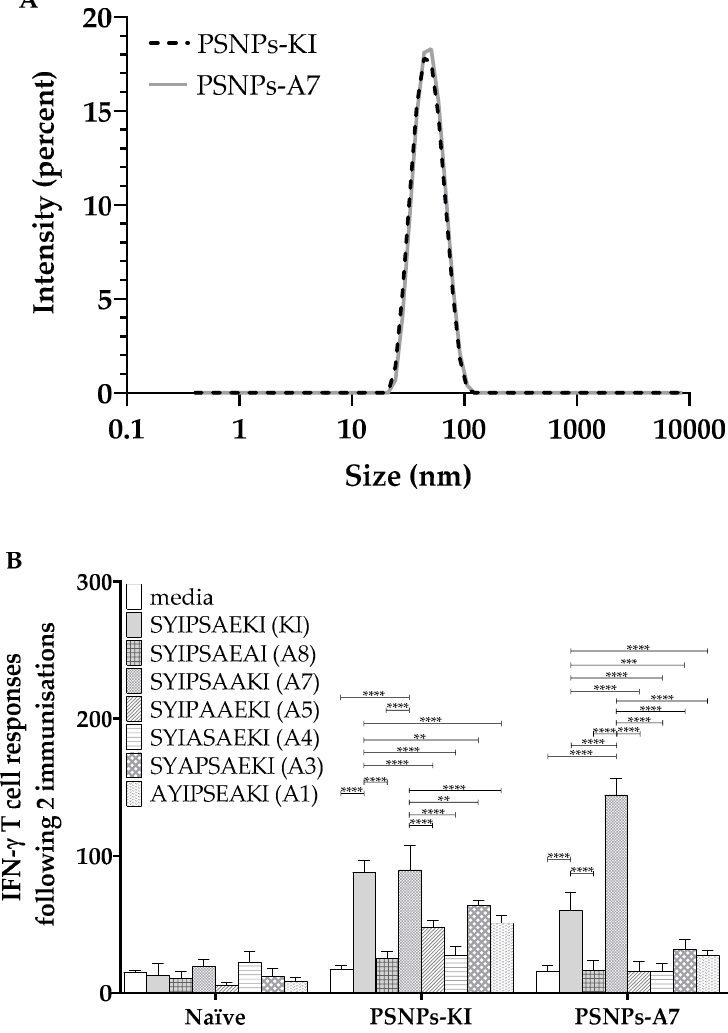
Figure 4. Cross-reactivity to both SYIPSAAKI (A7) and SYIPSAEKI (KI) when either peptide is conjugated to PSNPs. KI and A7 peptides were conjugated to PSNPs and sizes measured on a Malvern zetasizer ( A ). The 6–8 week old BALB/c mice were immunized twice with PBS alone or KI or A7 conjugated to PSNPs (25 µg per mouse KI and 0.72–0.92% solids PSNPs for both groups) ( B ). Thirteen days after the last immunization, splenocytes from immunized mice were harvested and restimulated with altered peptides in an in vitro ELISpot assay for IFN- γ . Data shown as mean +/- SD of SFU/million cells per assay triplicates (pooled cells from four mice per group). * p < 0.05, ** p < 0.01, *** p < 0.001, **** p < 0.0001.